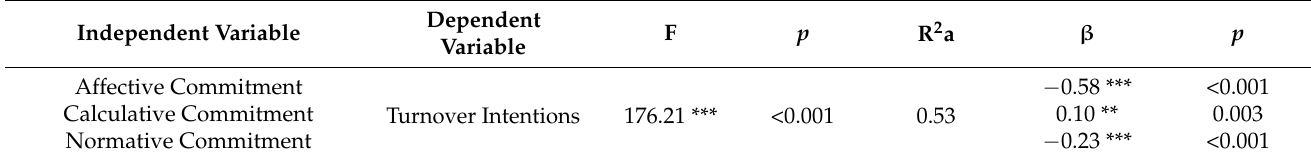
Table 6. Organisational Commitment and Turnover Intentions (H3).